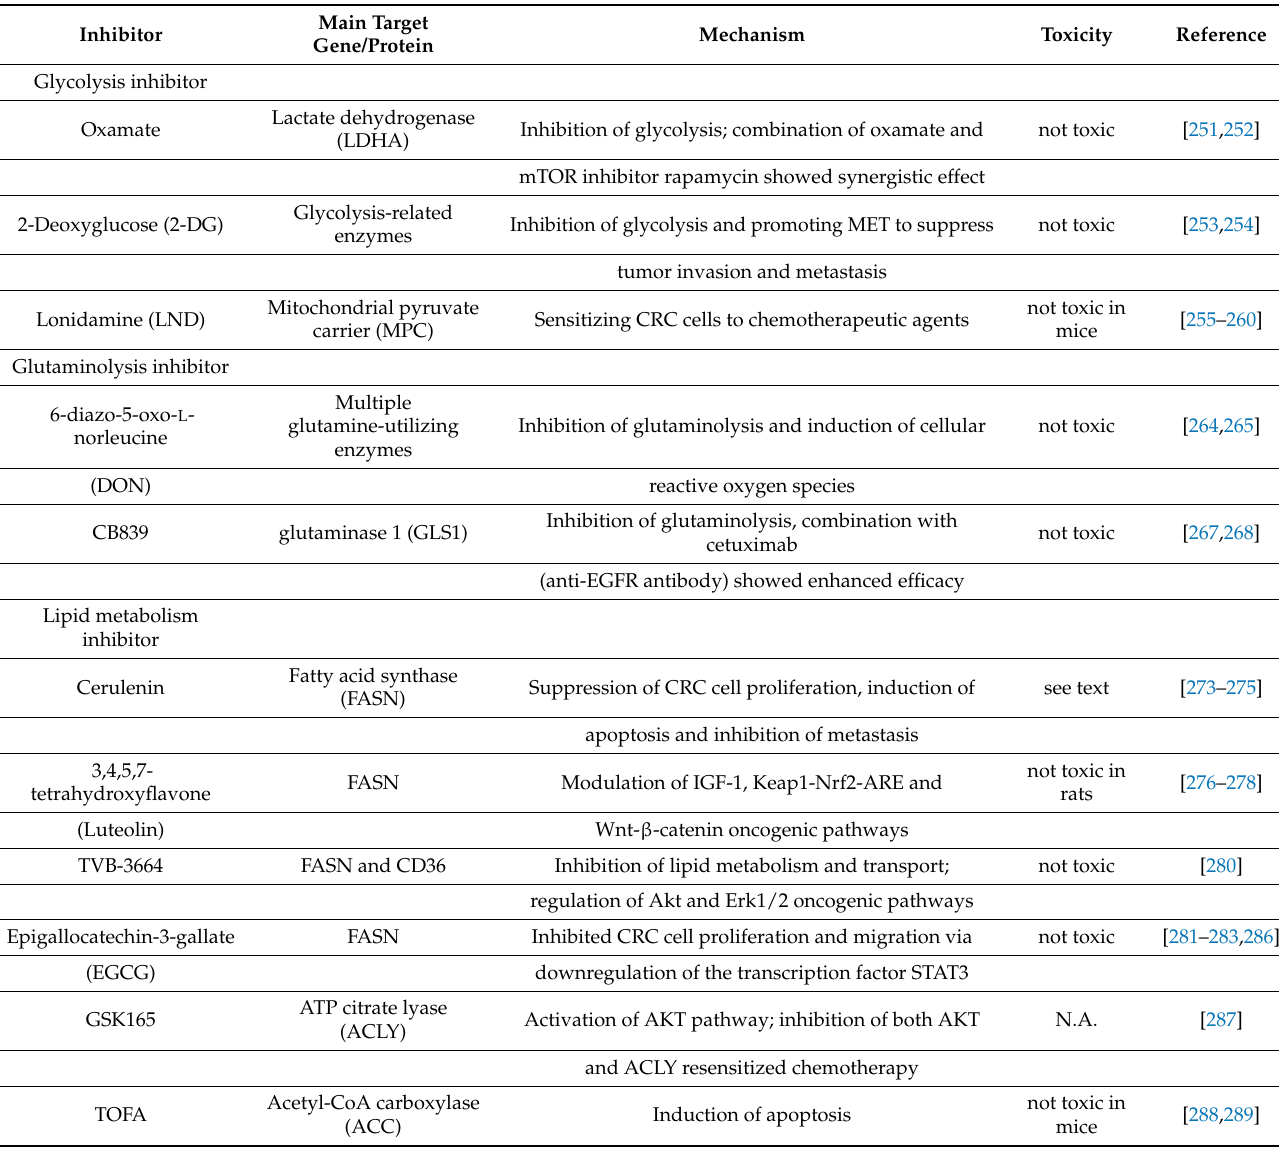
Table 1. Compounds targeting glucose, glutamine and lipid metabolism in